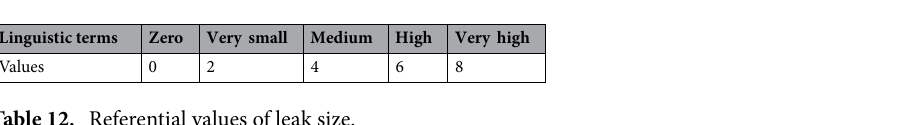
Table 12. Referential values of leak